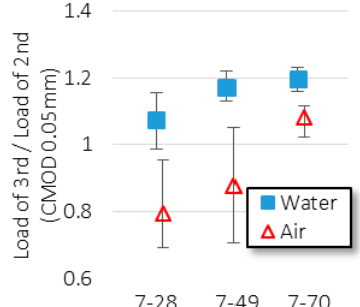
Figure 10. Ratios between the load of the 3rd loading and the load of the 2nd loading with CMOD = 0.05 mm (different healing periods).